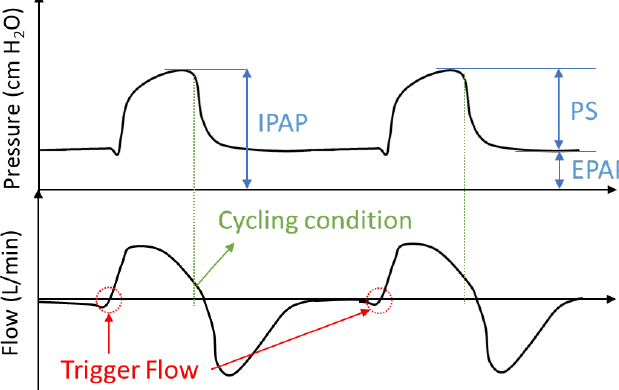
Figure 2. Example of the trigger and cycling condition in assisted mode.